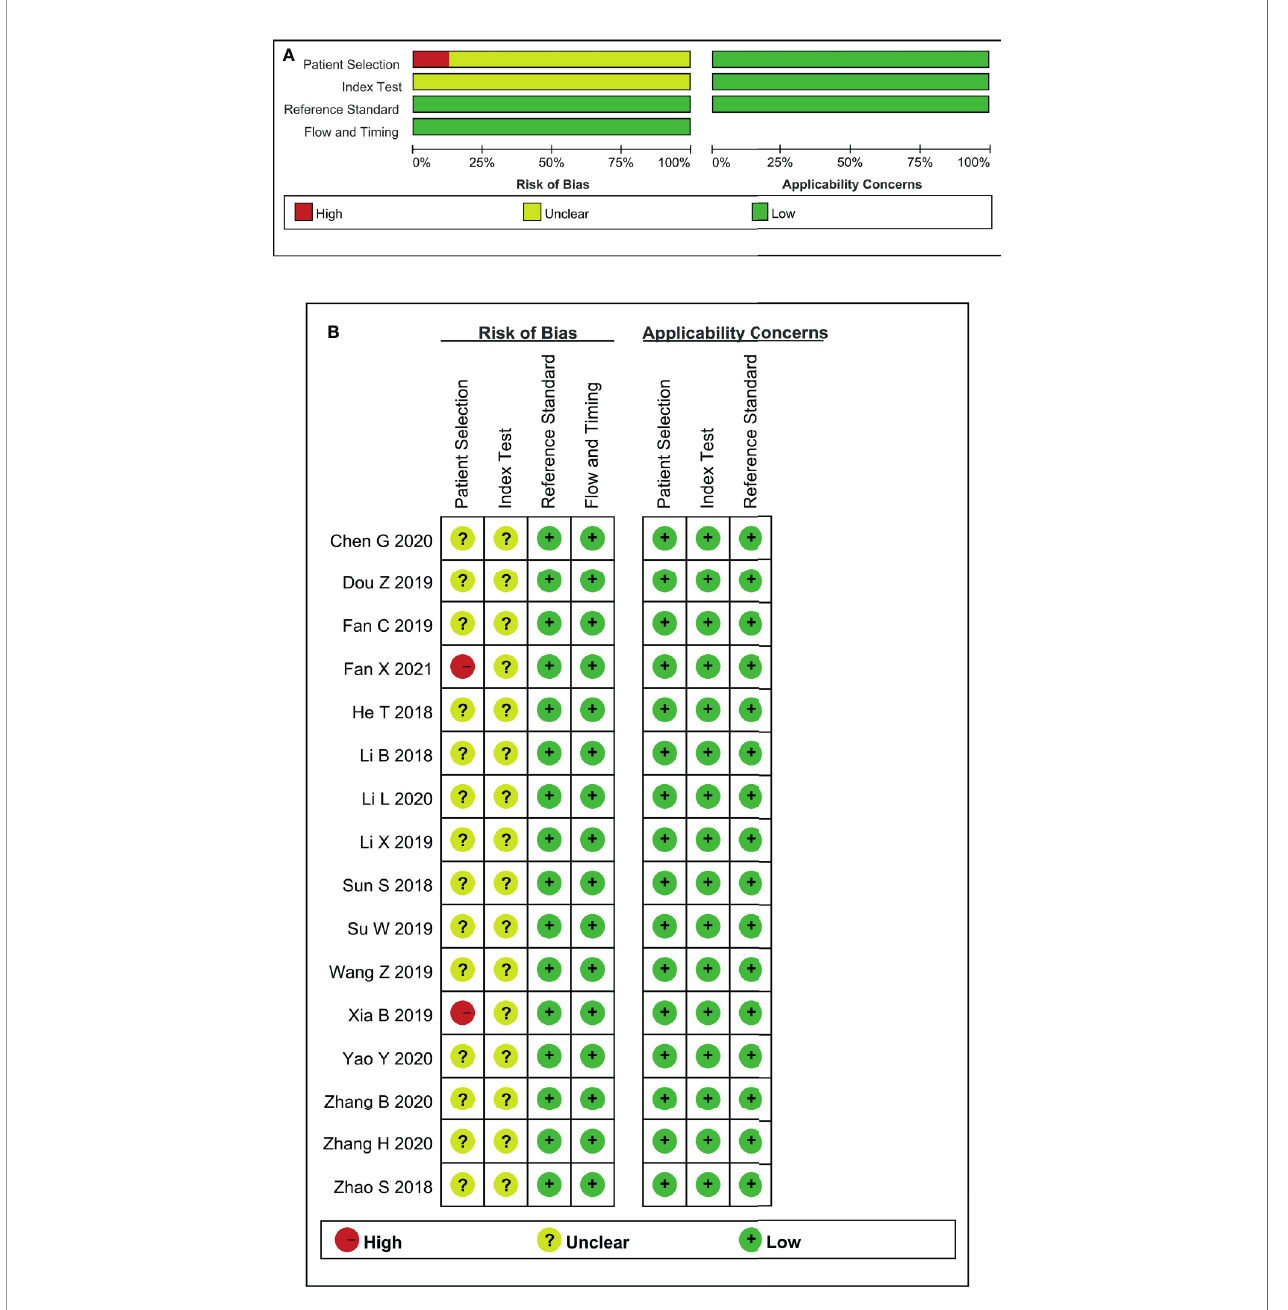
FIGURE 2 | Quality assessment of the included studies according to QUADAS-2 (A) Methodological quality graph; (B) Methodological quality